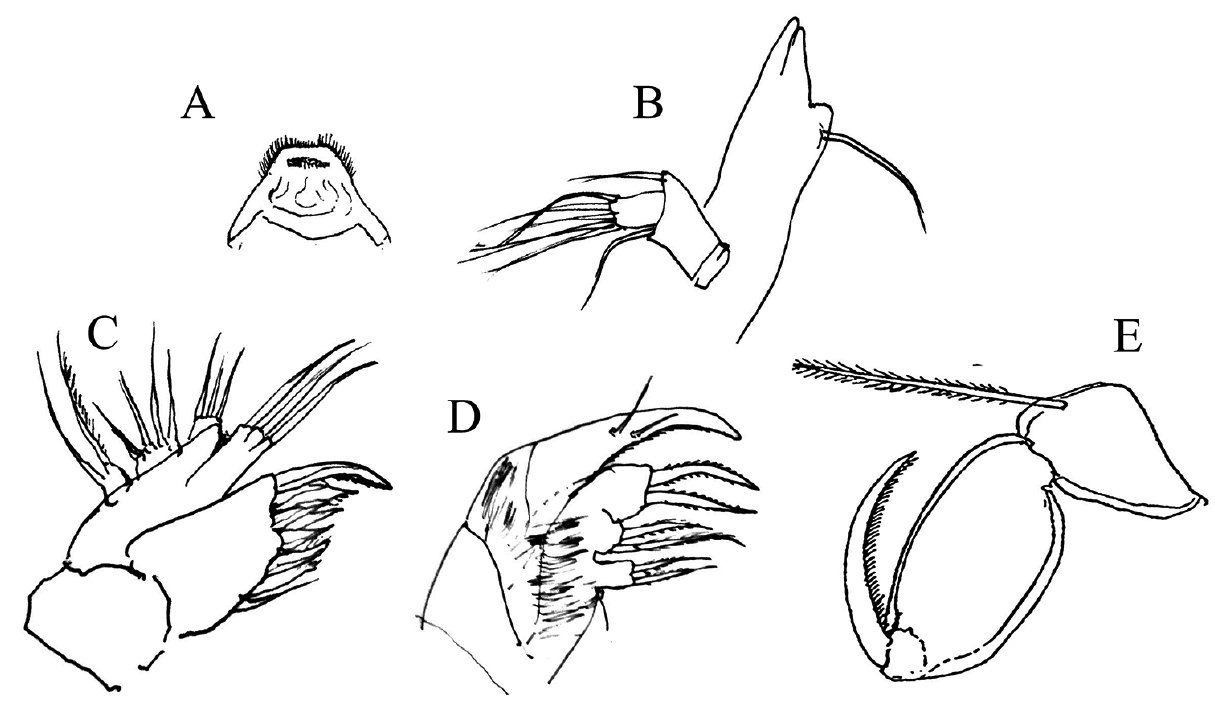
Figure 4. Eudactylopus fasciatus Sewell, 1940, female. A, Labrum; B, mandible; C, maxillule; D, maxilla; E, maxilliped. Scale bar: 100